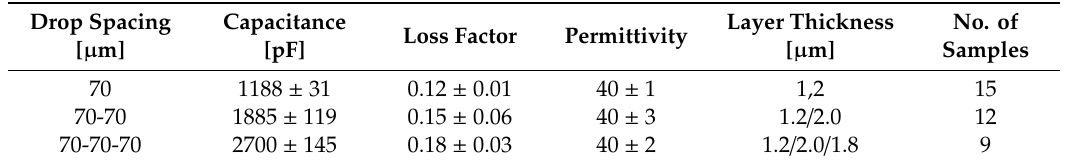
Table 1. Capacitances, loss factors, permittivities and layer thicknesses of the multilayer capacitors with a drop spacing of each 70 µ m. The measurements were carried out at 200 kHz and are averaged over 5 individual values for every single